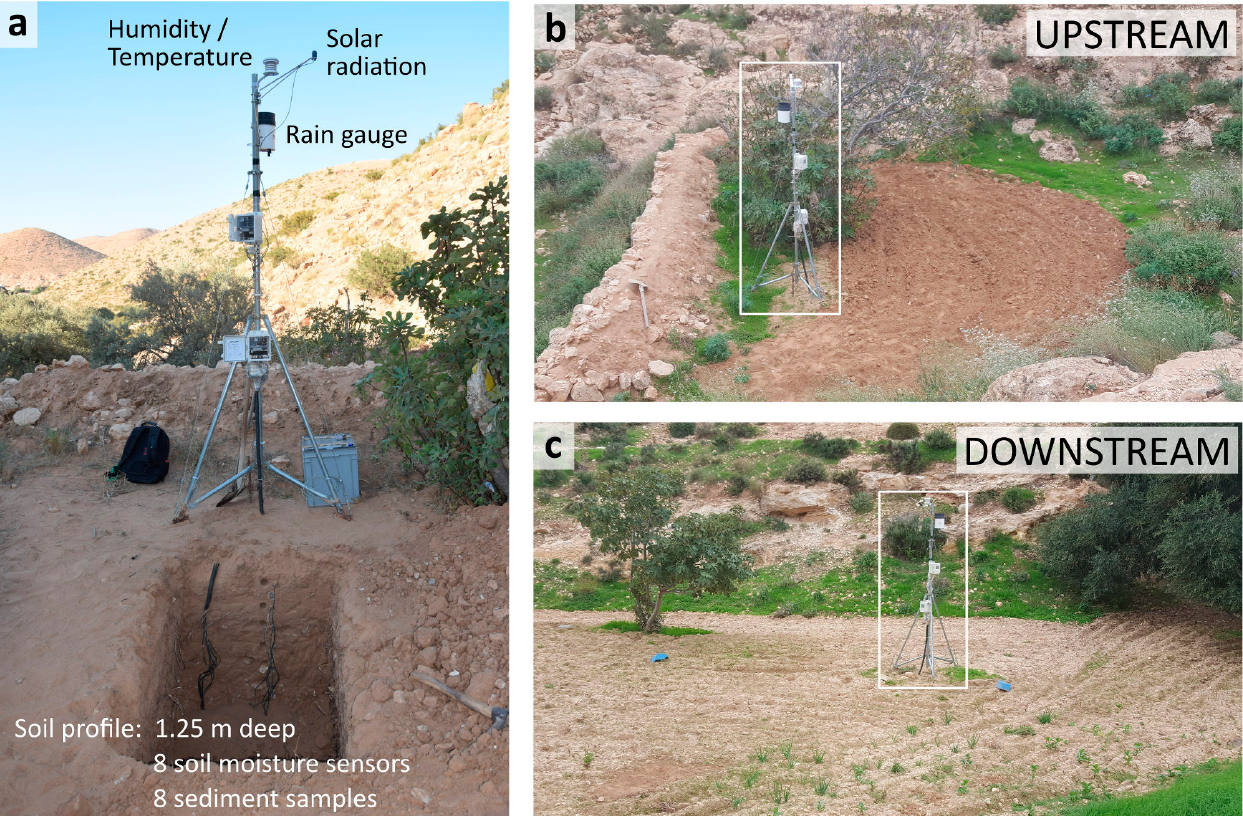
Figure 4. Configuration of the measurement station ( a ); location in upstream Jesr ( b ) and downstream Jesr ( c ). Photos: T. Ben Fraj and M. Abbassi.